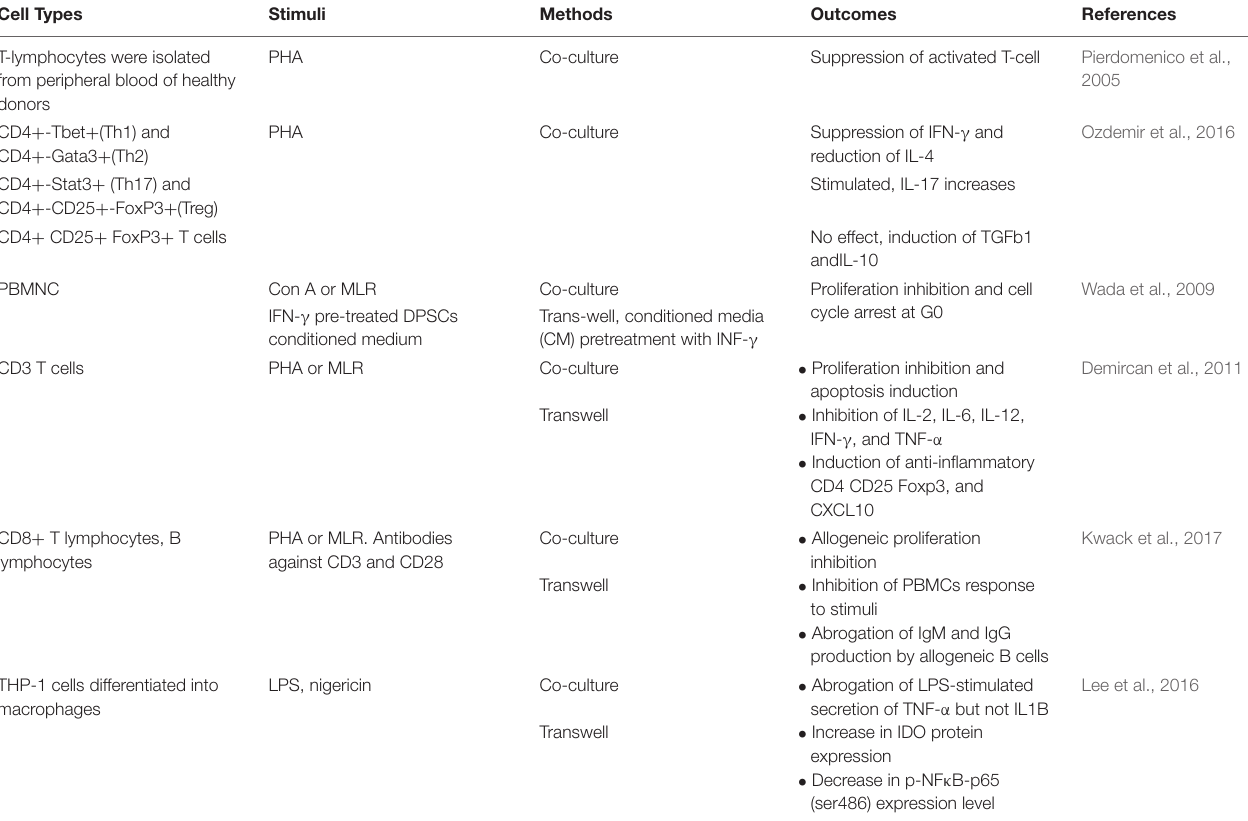
TABLE 3 | Immunomodulatory profile of DPSCs reported in different